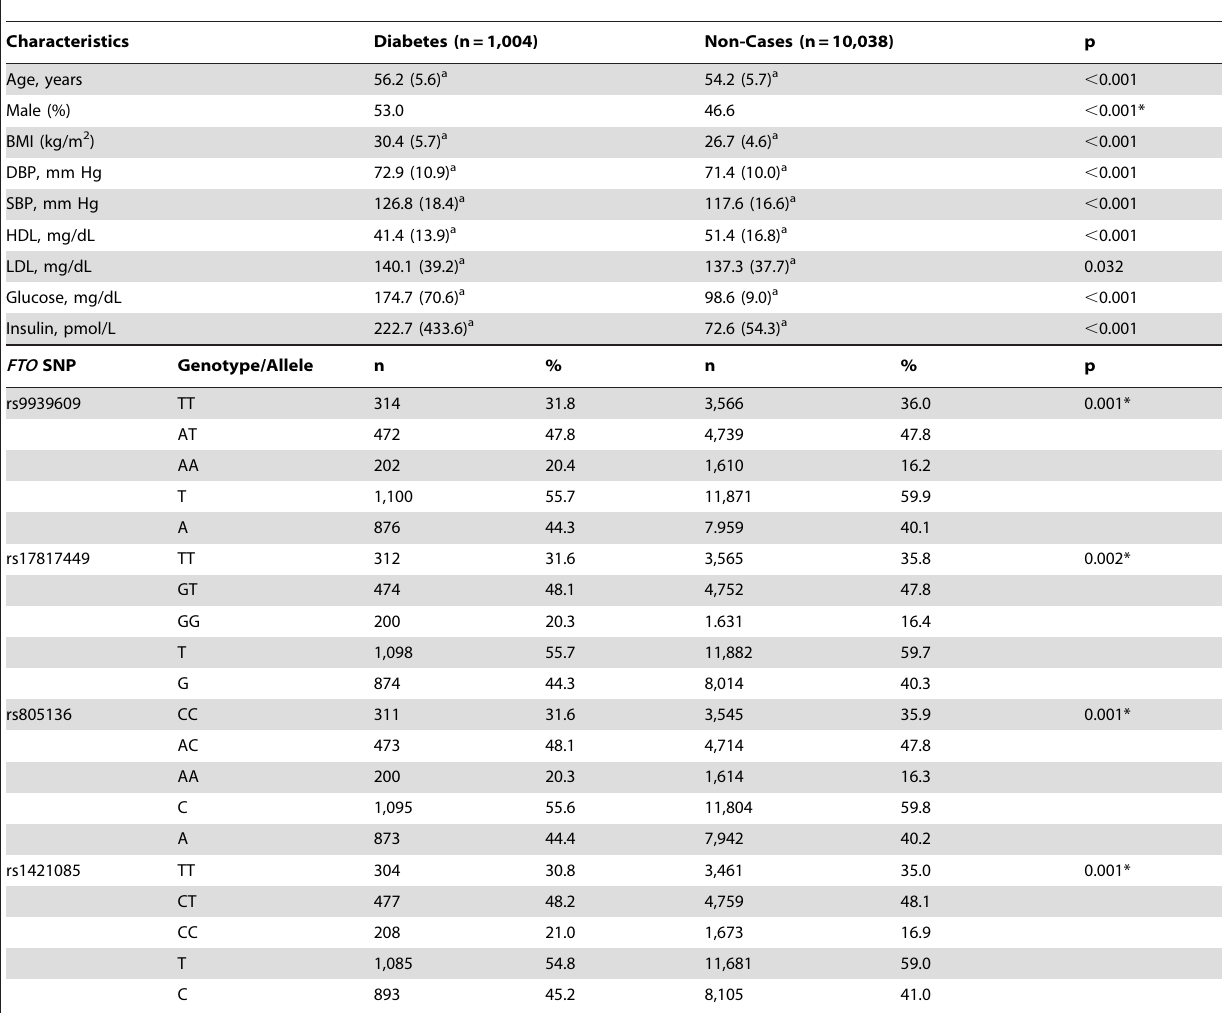
Table 2. Clinical characteristics and FTO SNP genotype frequencies in whites stratified by diabetes case status.